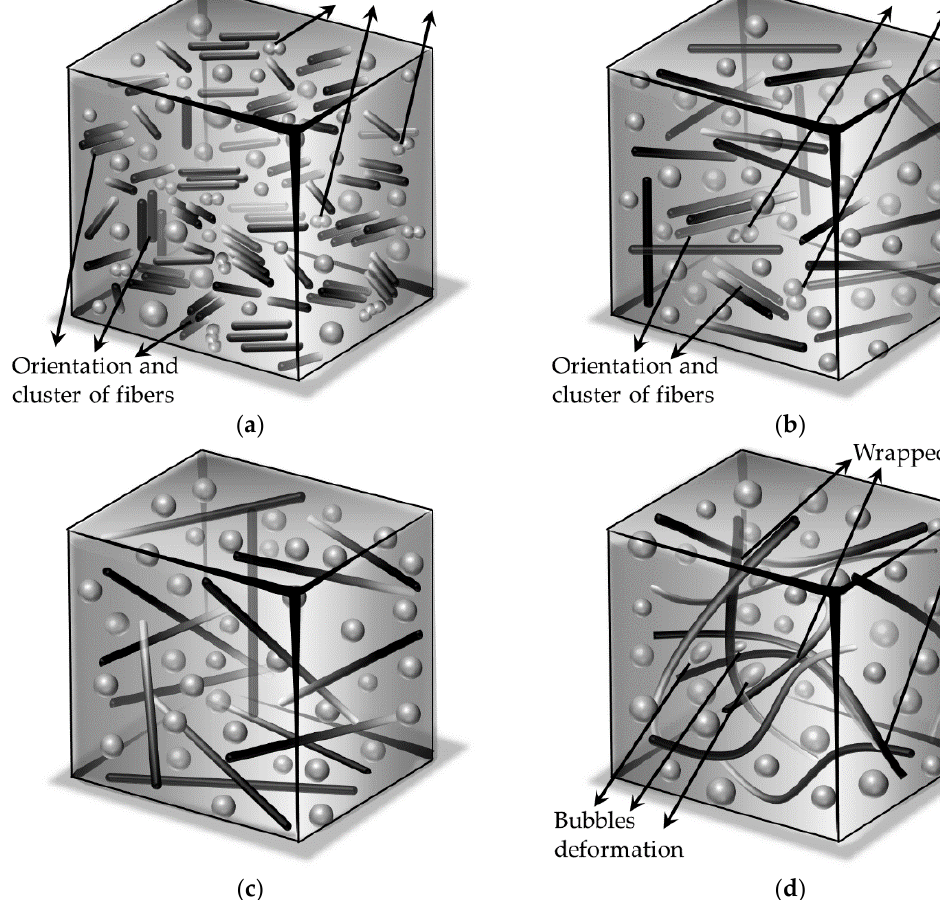
Figure 10. Schematic diagrams of distributions of bubbles and 20.00 phr of chopped glass fiber: ( a ) at a length of 3.0 mm, ( b ) at a length of 9.0 mm, ( c ) at a length of 15.0 mm, ( d ) at a length of 21.0 mm in cured samples.